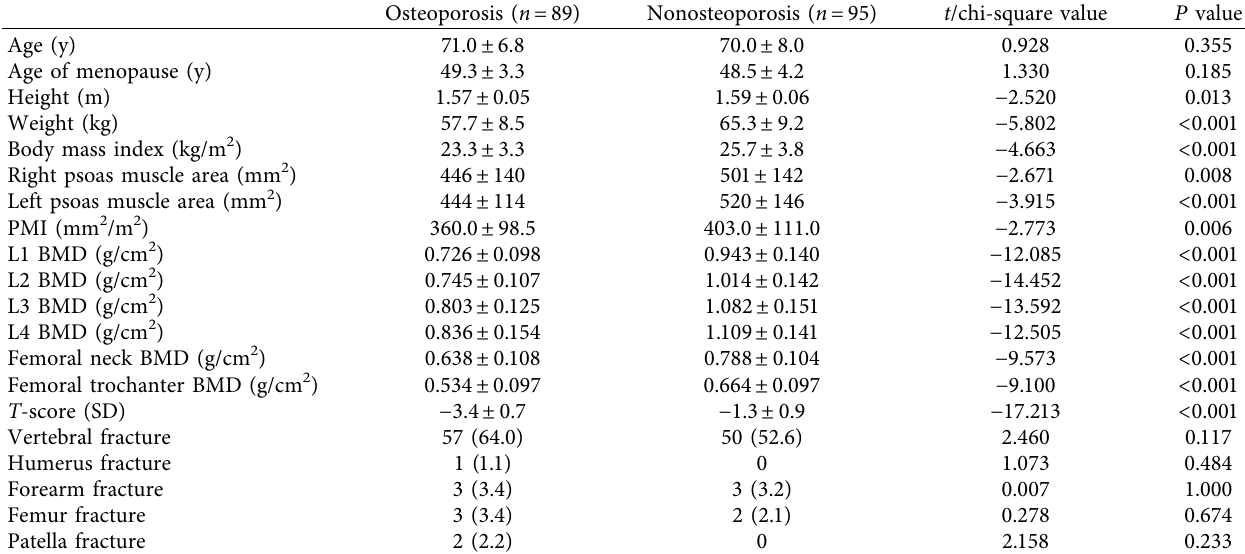
Figure 1: Te two images are the CT scan localization image and the CT axial image of a 58-year-old woman with a height of 1.6 m, respectively. (a) Te localization image showed that plane of the line 28 was the middle level of the L3 vertebral body. (b) One radiologist manually delineated the edge of the bilateral psoas muscle on the CT axial image of the L3 level. Te bilateral psoas muscle area was calculated automatically by the software. Te right psoas muscle area was 663mm 2 , and the left psoas muscle area was 662mm 2 . According to the calculation formula, the PMI was equal to 517.6mm 2 /m 2 . Table 1: Baseline